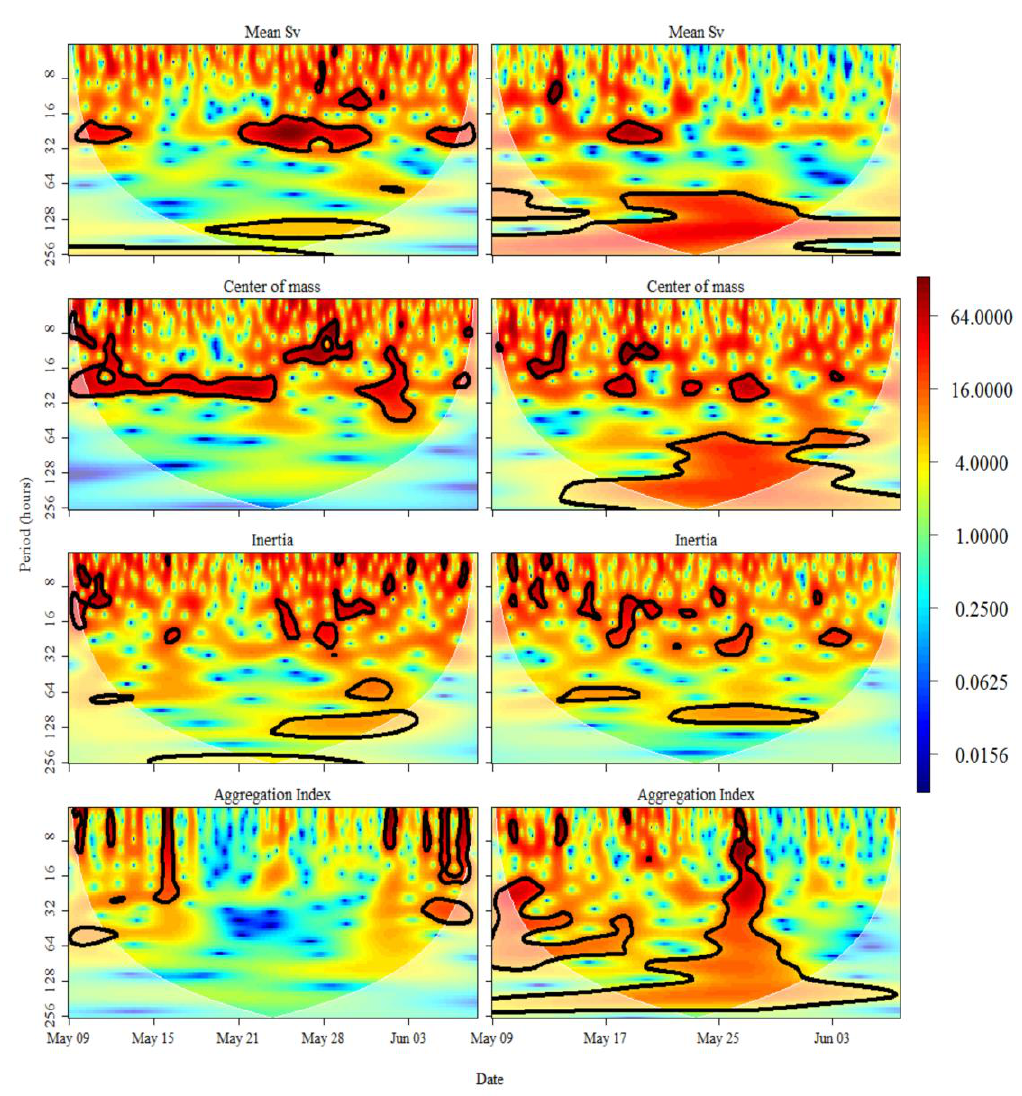
Fig. 3. Wavelet decomposition of the temporal variability in pelagic fish and macrozooplankton characteristics (Mean Sv, center of mass, inertia, and aggregation index) at Admiralty Inlet (WA) tidal site (left panel) and the PacWave energy site (right panel). Areas of significance are traced with a black line. Color bar represents wavelet power ( 𝜎 2